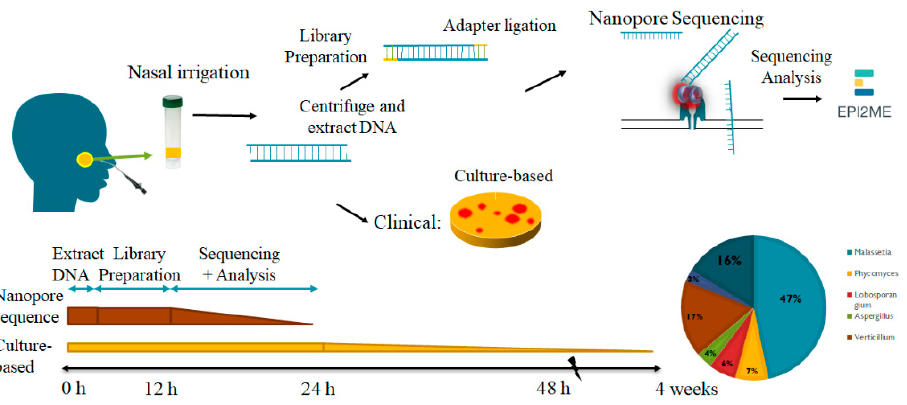
Figure 1. Schematic representation of the culture-based method and oxford nanopore sequencing process. The clinical culture-based system needs more than one month for fungal growth. The nanopore sequencing system only needs 24 h to identify